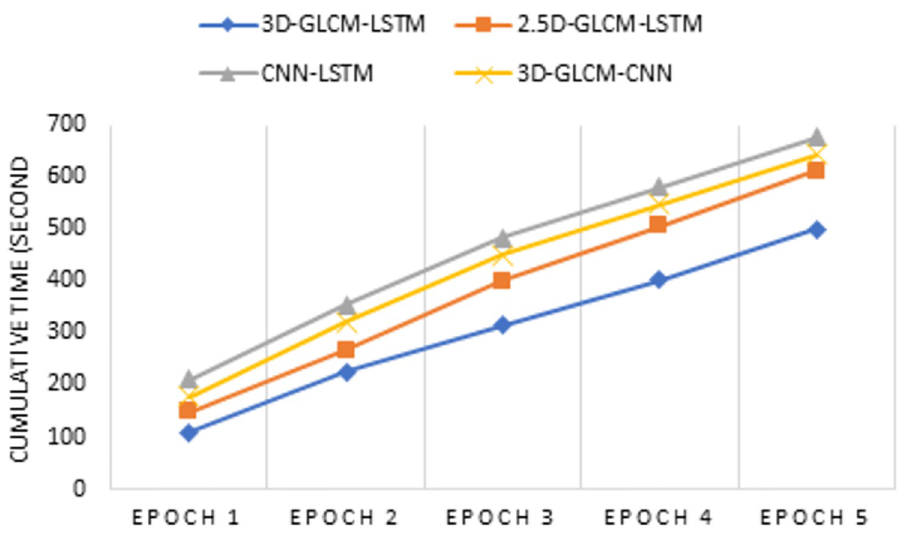
Fig 11. The training time of different models for five epochs.